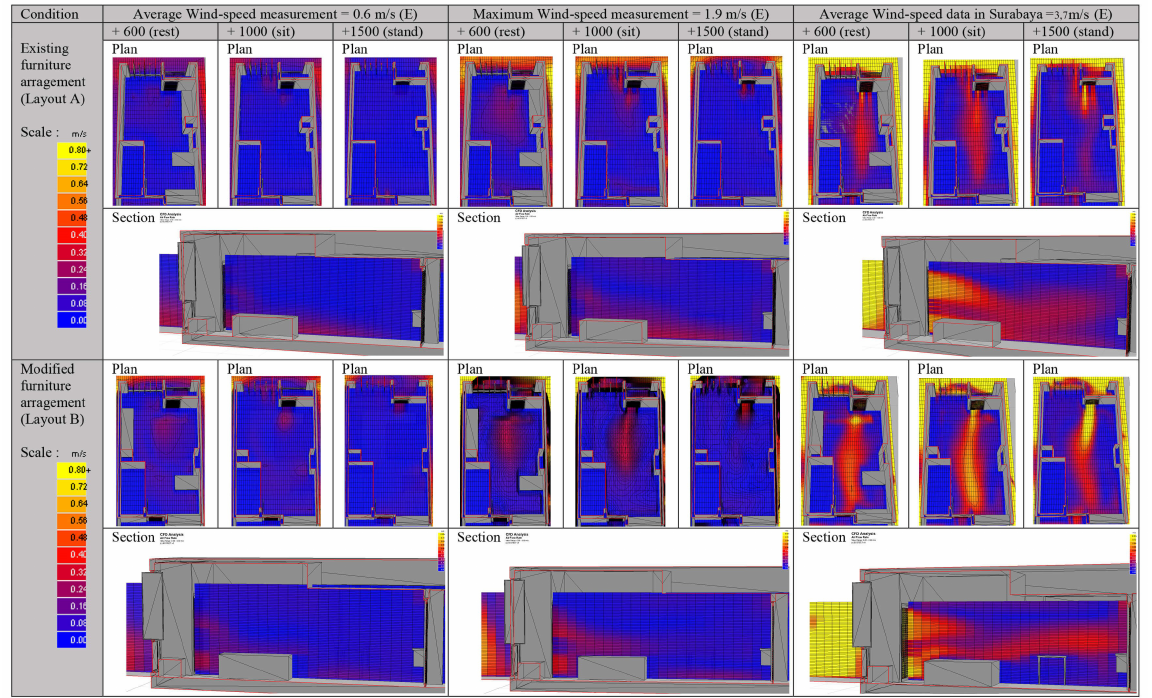
Fig. 4. Condition 2a and b: Changing Existing Window to Operable Pivot Window, Adding Opening Above The Pantry, and Using Gauze Doors.